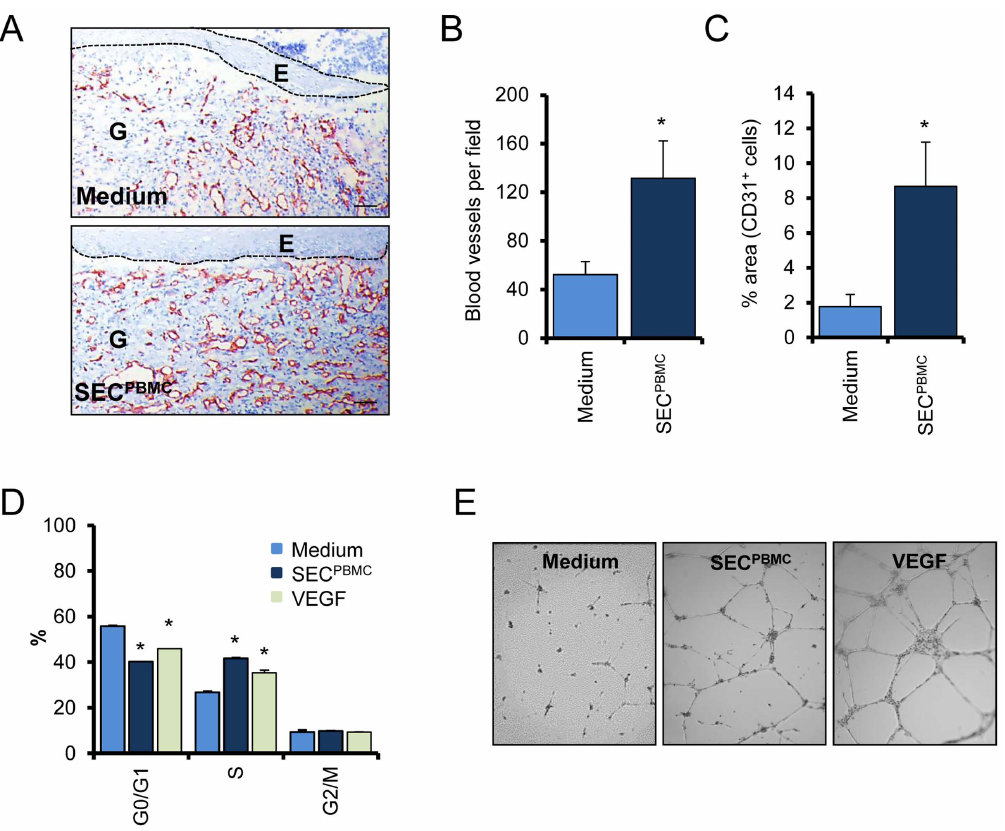
Figure 3. SEC PBMC induces formation of new blood vessels. ( A ) Representative CD31 stainings of wounds underneath the original wound edge are shown. Scale bars: 50 m m ( B ) The numbers of CD31 positive cells underneath the newly formed epidermis were evaluated. The graph represents the mean of 15 animals in each group (*: p , 0.01). ( C ) The area of the granulation tissue taken up by CD31 + cells was evaluated. The graph represents the mean of 15 animals in each group. ( D ) Cell cycle analysis of SEC PBMC treated microvascular EC shows a strong increase in proliferating cells. VEGF treatment served as positive control. One representative experiment of three each done in triplicates is shown (*: p , 0.01). ( E ) A tube formation assay is shown. Compared to medium alone SEC PBMC strongly induced tube formation in a matrigel assay. One representative experiment of three is shown.